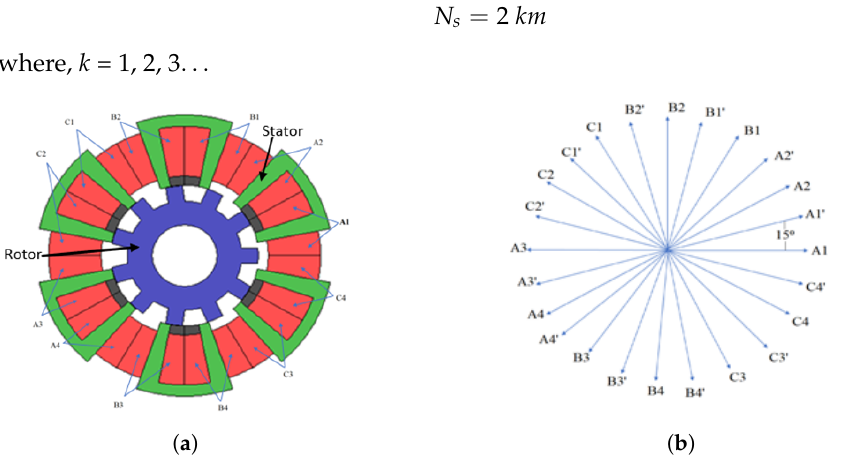
Figure 1. Coil-phase arrangement of the proposed model. ( a ) Phase-coil connections. ( b ) Phase-coil connection